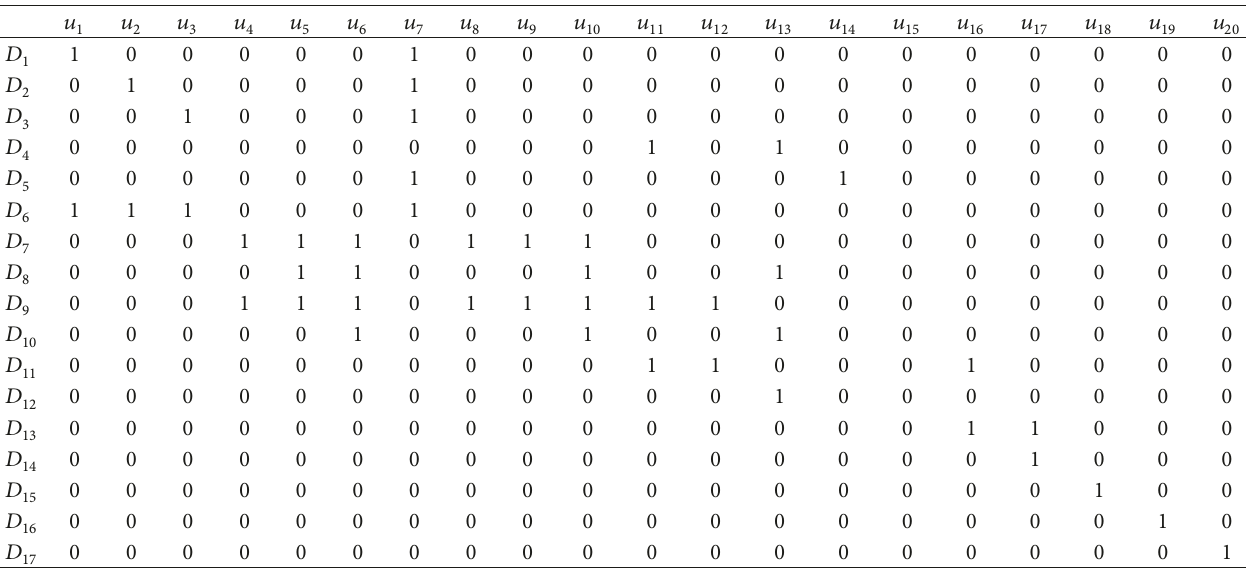
Table 1: Typical fault-symptom relation of air